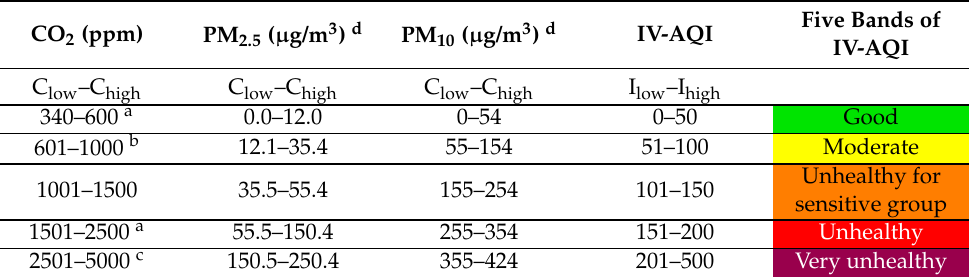
Table 1. Breakpoint concentration of the in-vehicle air